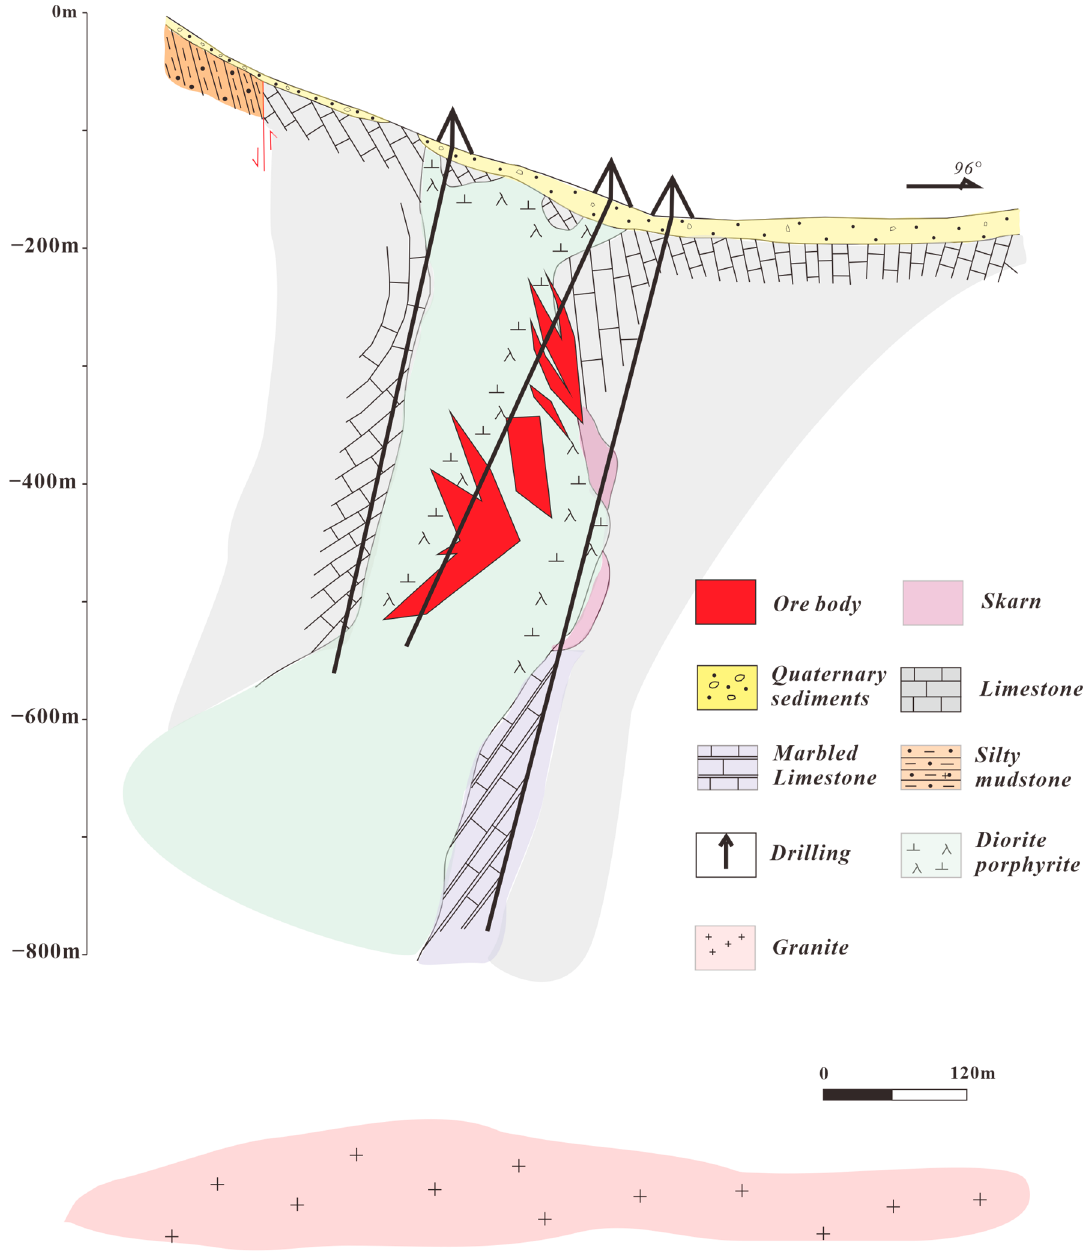
Figure 11. Geological profile of the Xiaoyangchong zinc–iron deposit in the FVB (modified from [77,113]).